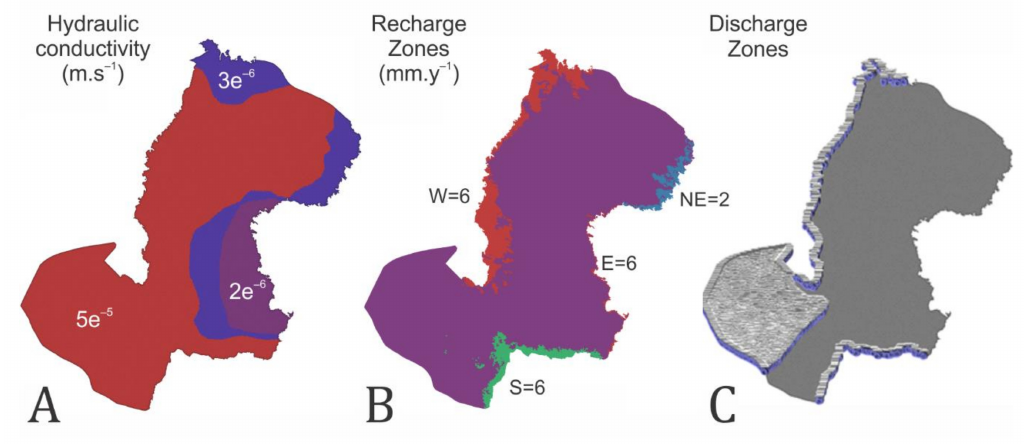
Figure 5. Distributions of ( A ) the hydraulic conductivity, ( B ) recharge zones, and ( C ) discharge